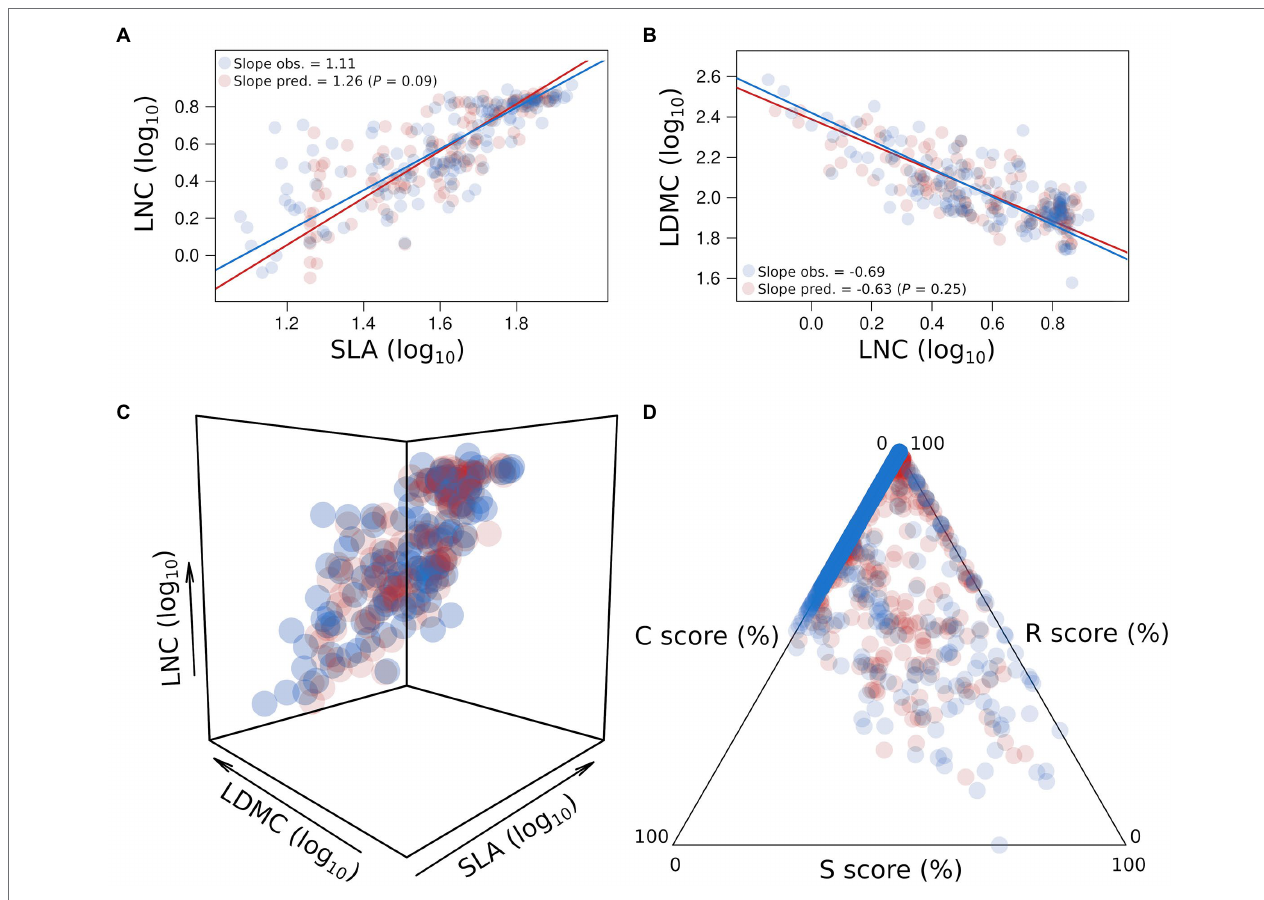
FIGURE 1 | Predictions of the leaf economics spectrum and CSR strategies. Log 10 relationships between specific leaf area (SLA, mm 2 mg − 1 ) and leaf nitrogen content (LNC, %; A ); between leaf nitrogen content (LNC, %) and leaf dry matter content (LDMC, mg g − 1 ; B ). Only predicted values in the validation dataset (1/4 of the whole dataset, n = 123) were plotted here. Observed trait values are colored in blue and predicted trait values are colored in red. Regression lines have been estimated by standard major axis (SMA). P is the p value of the SMA test of slope difference between observed and predicted relationships. (C) 3D representation of the leaf economics spectrum between observed and predicted trait values in the validation dataset ( n = 123). (D) CSR triangle between observed and predicted trait values in the validation dataset ( n = 699) depicting the variation of plant ecological strategies between competitive ability (C), stress-tolerance (S), and ruderalism